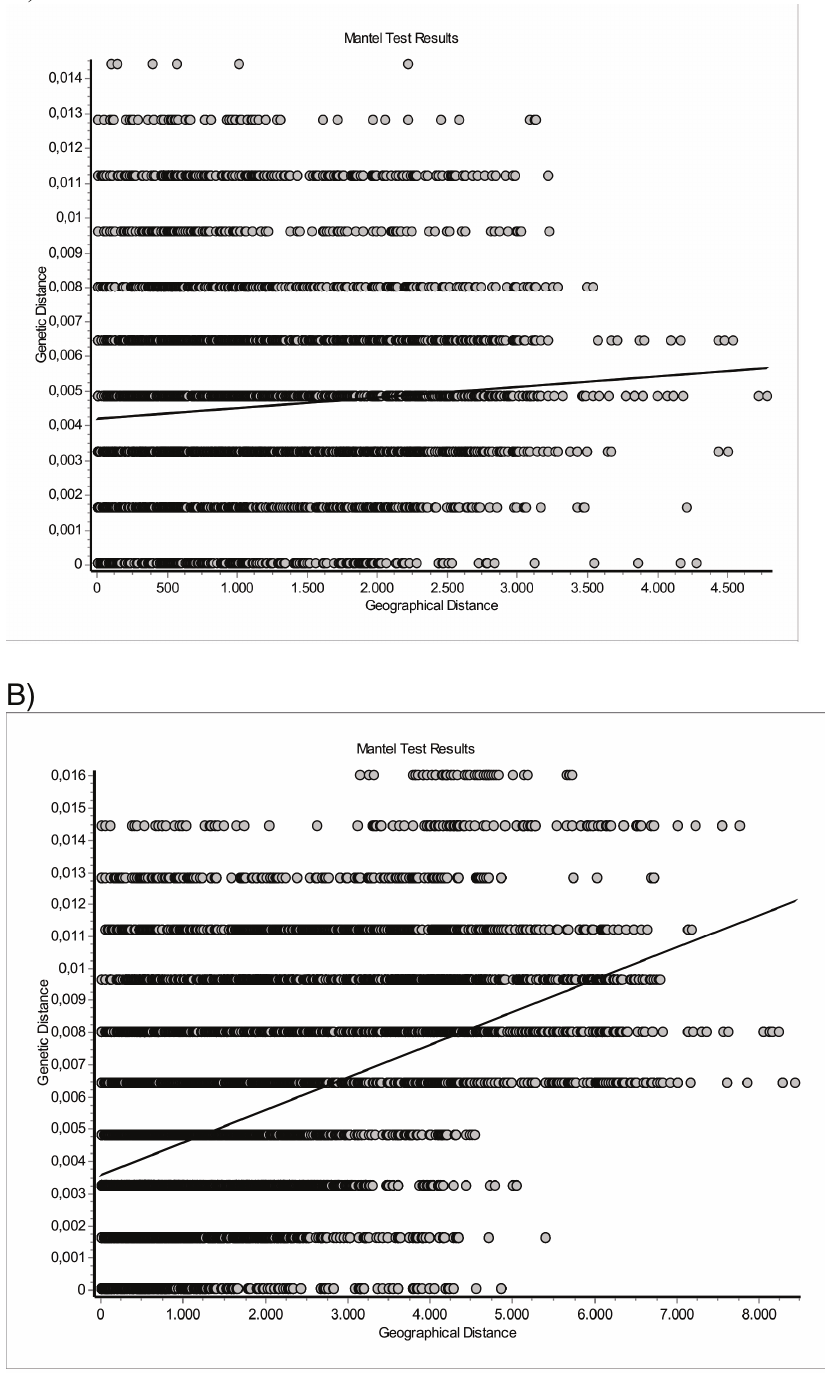
Figure S1. Graph depicting the correlation between genetic and geographic distances